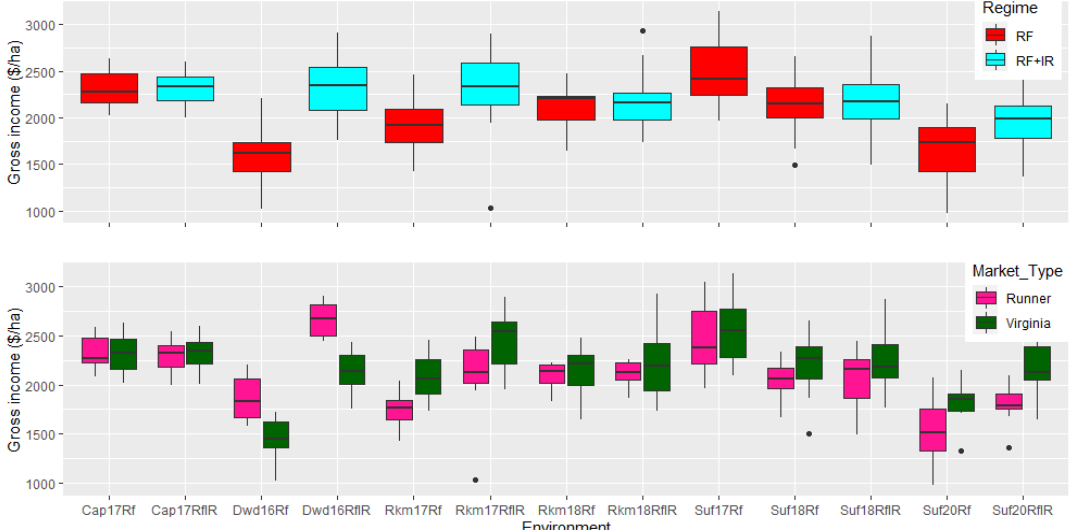
Figure 2. Boxplot for the effect of water regime and market type on gross income (USD/ha) of 5 Virginia and runner peanut cultivars in 13 environments. Each plot indicates total range, interquartile range (box), and median (line). Environment names are coded and the first three letters indicate location: Cap, Capron, VA; Dwd, Dinwiddie, VA; RM, Rocky Mount, NC; Suf, Suffolk, VA; two digits indicate year of the trial; 16 for 2016, 17 for 2017, 18 for 2018, 20 for 2020; and the last letters Rf and RfIR for water regime: Rf, rainfed, RfIR, rainfed plus irrigated. The upper part of the figure shows the effect of water regime and the lower part the effect of market type on the gross income in 13 environments.